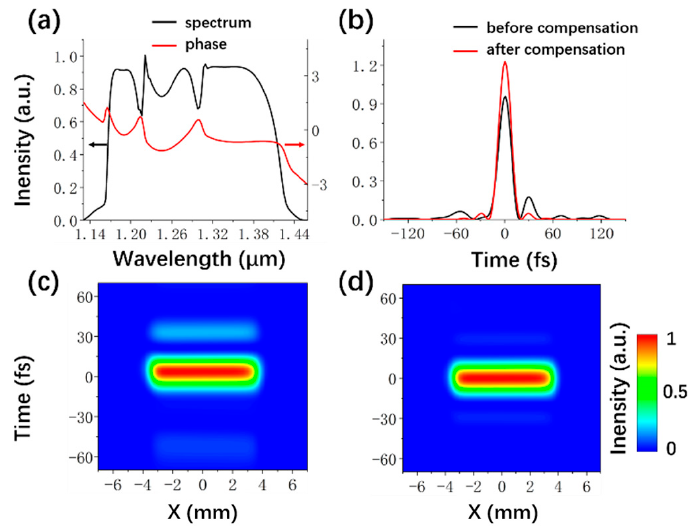
Figure 7. ( a ) The amplified spectrum and the spectral phase with dispersion compensation up to TOD for triple-crystal scenario, ( b ) the temporal profiles of signal before and after the residual high order dispersion is compensated, the temporal distributions of the signal along X axis ( c ) before and ( d ) after the compensation of the high order dispersion.